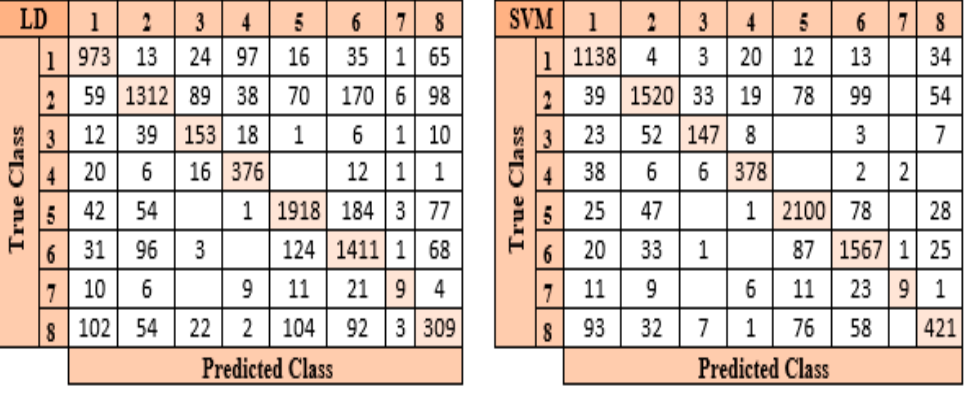
Figure 9. Confusion matrices of the classifiers with the highest accuracy in the LBP method.